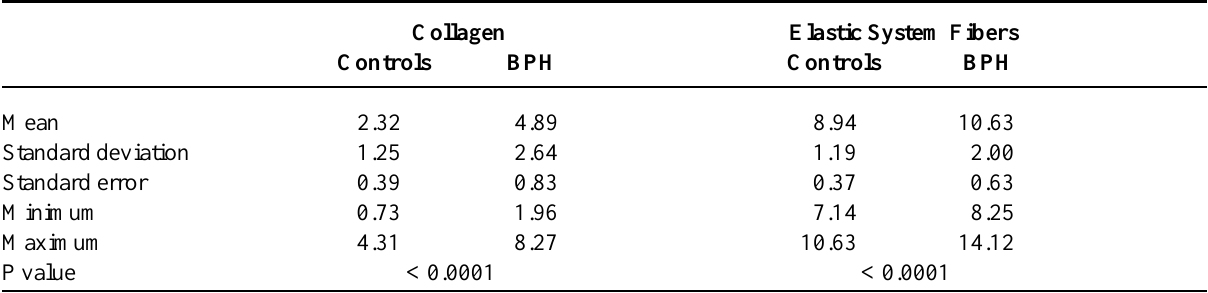
Table 1 – The volumetric density in percentage of collagen and elastic system fibers in the bladder of controls (n = 10) and benign prostate hyperplasia (BPH) samples (n =